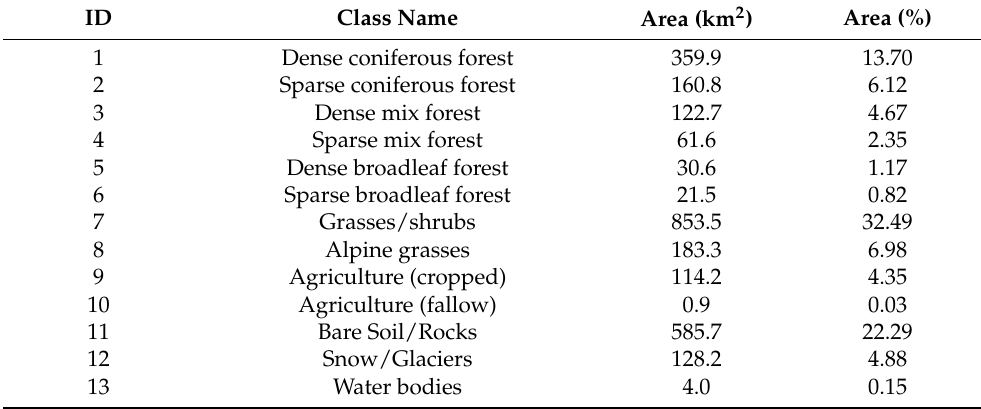
Figure 2. Land-cover classes of the KRB. Table 1. Land-cover classes of the